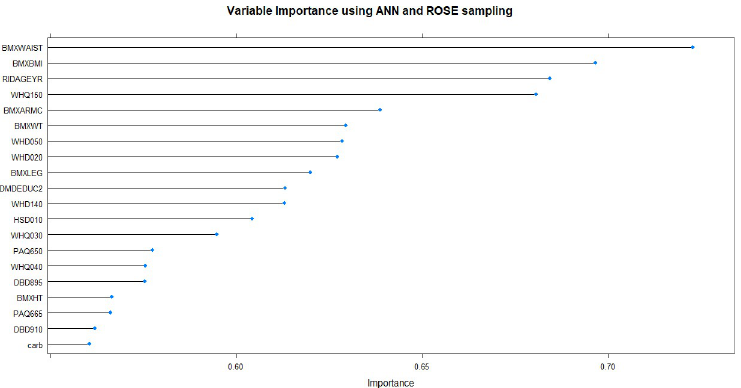
Fig 9. Variable importance plot of the best-performing artificial neural network model produced by ROSE resampling. BMXWAIST = waist circumference; BMXBMI = body mass index; RIDAGEYR = age; WHQ150 = age when heaviest weight; BMXARMC = arm circumference; BMXWT = weight; WHD050 = self-reported weight– 1 year ago; WHD020 = current self-reported weight; BMXLEG = upper leg length; DMDEDUC2 = education level; WHD140 = self-reported greatest weight; HSD010 = self-rated general health; WHQ030 = How do you consider your weight?; PAQ650 = vigorous recreational activities; WHQ040 = Like to weigh more, less, or same?; DBD895 = number of meals not home prepared; BMXHT = standing height; PAQ665 = moderate recreational activities; DBD910 = number of frozen meals/pizzas in past 30 days; carb = carbohydrate.